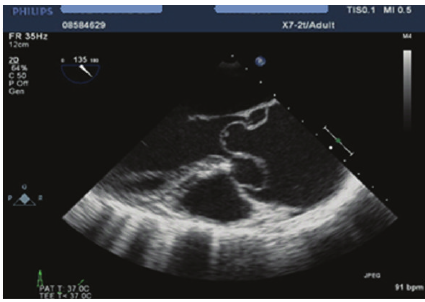
Figure 1: Transoesophageal echocardiogram showing Type A aortic dissection with e ff acement of the sinotubular junction.